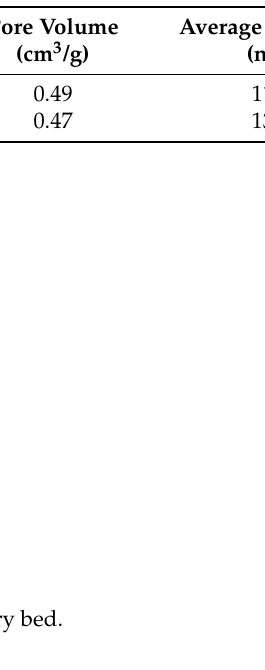
Table 11. Attrition index and physical properties of Cat-1 and Cat-1B.